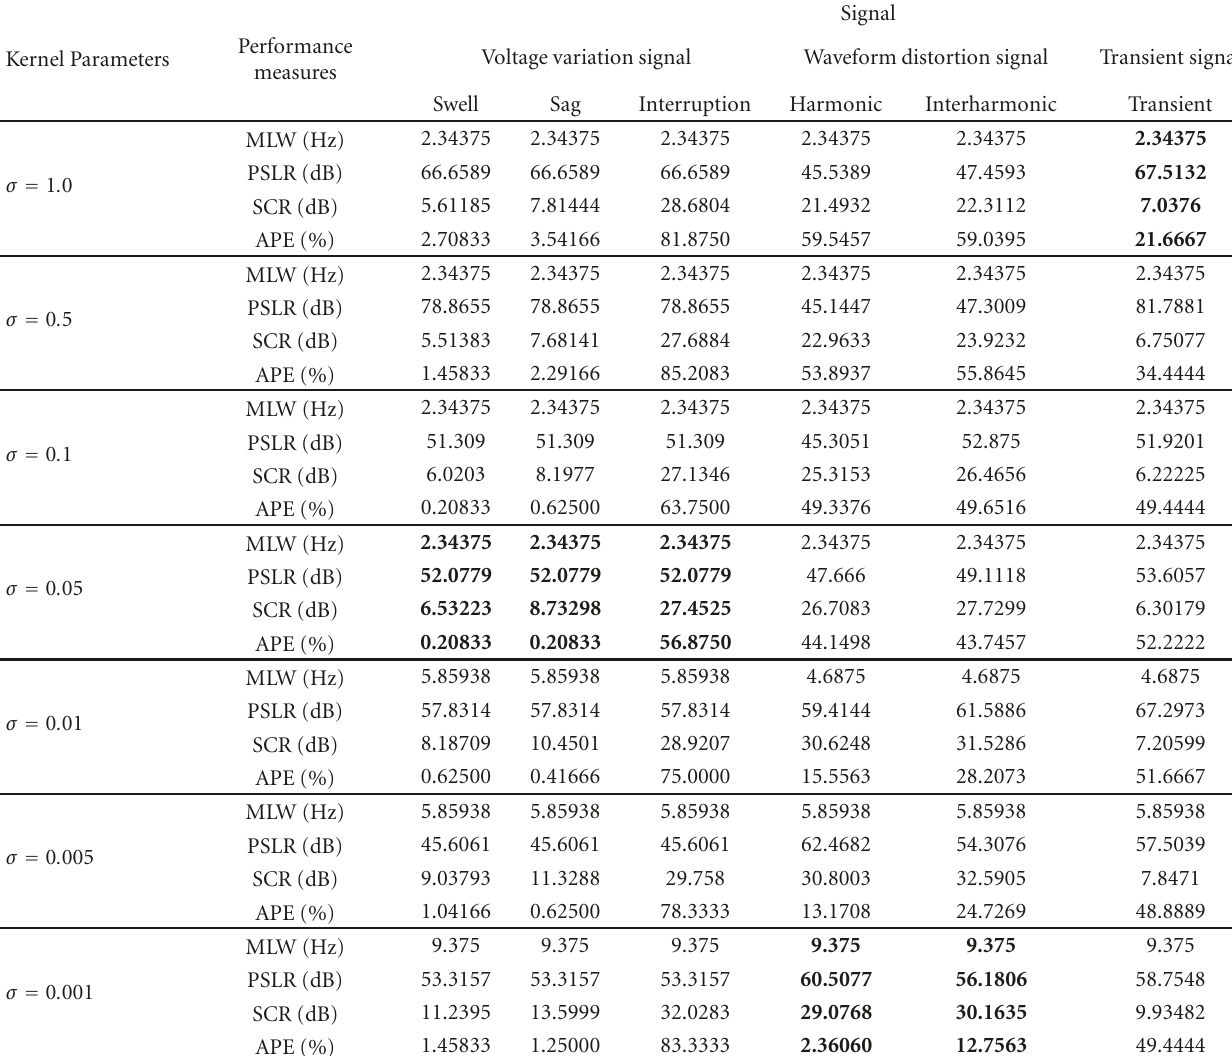
Table 4: Performance comparison of Choi-Williams